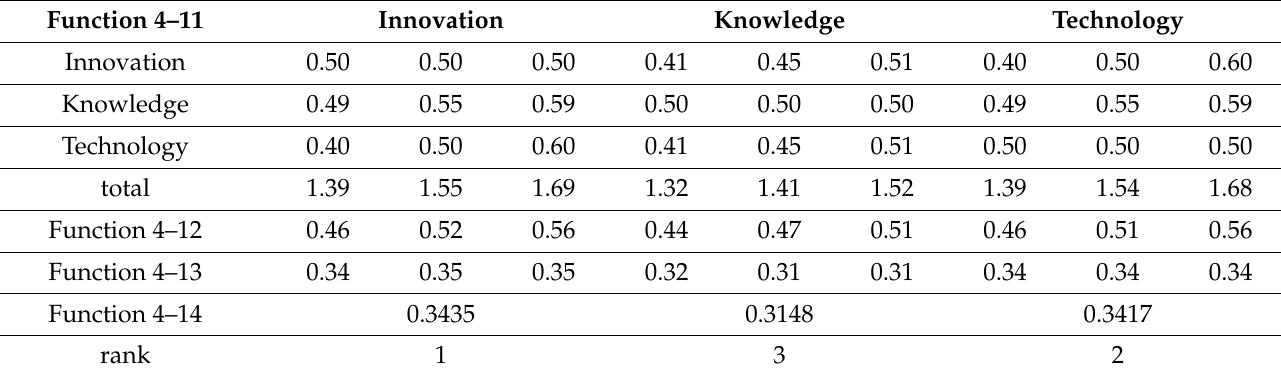
Table A13. Travel agencies’ weights of attributes of the epistemic